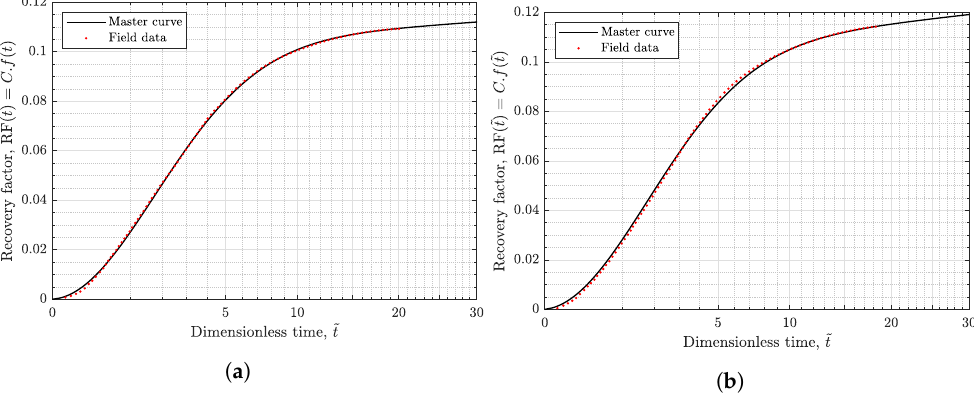
Figure A10. Comparison between the master curves in Equation (A34) and field data from Permian Basin: ( a ) K E = 0.022 and ( b ) K E =